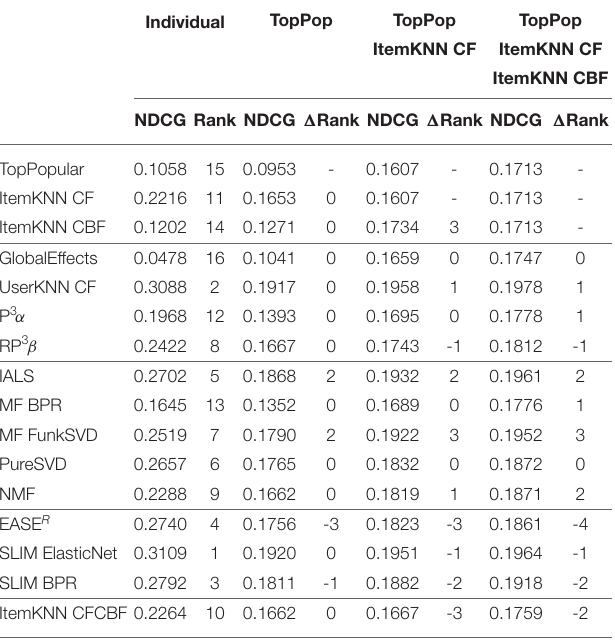
TABLE 2 | Comparison of the NDCG at 10 and overall model ranking for Movielens 20M. Carousel layout TopPop TopPop Individual